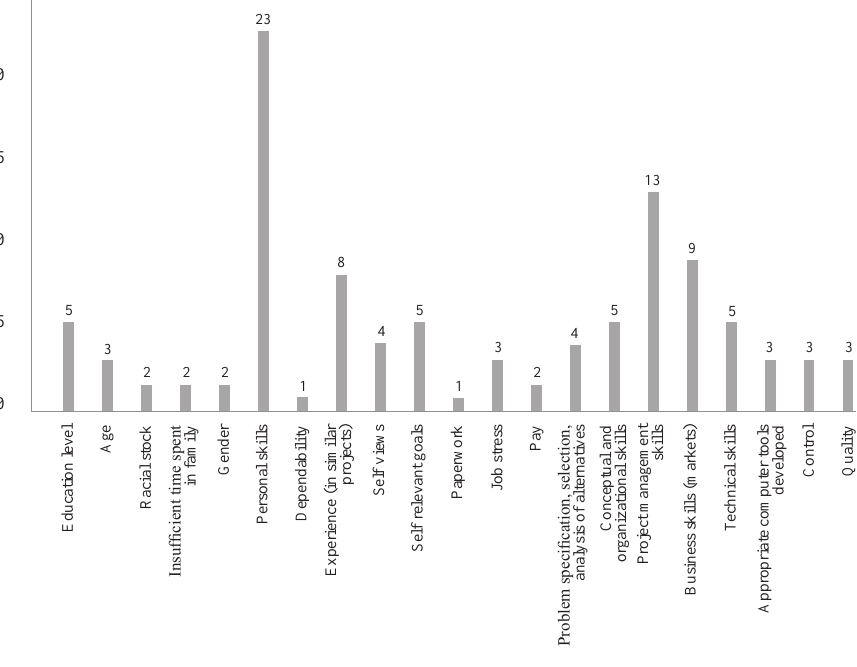
Fig. 2. The most important criteria of project manager selection in construction (the points indicate how many times they are mentioned in the reviewed